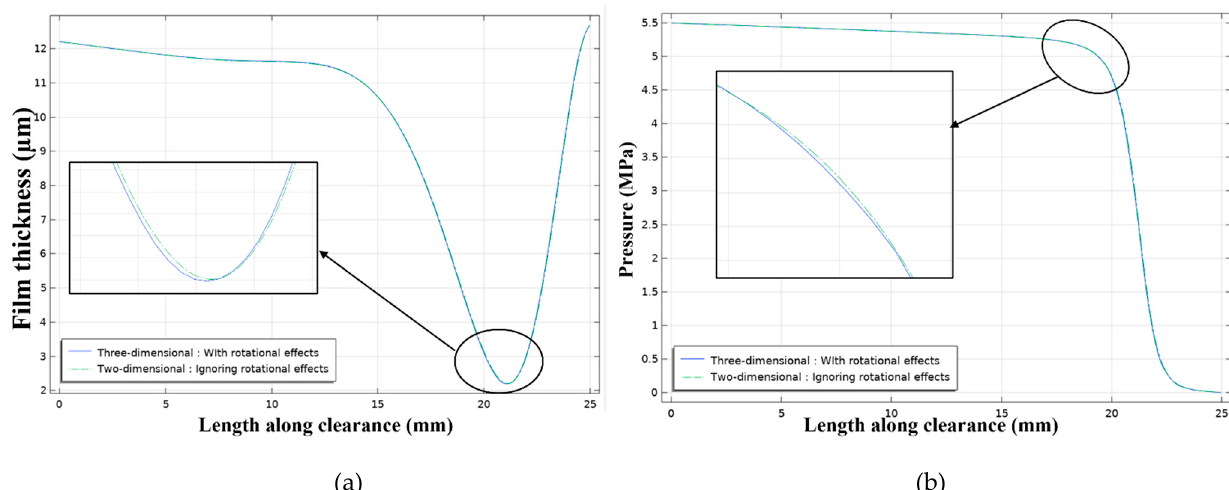
Figure 10. Comparisons of the simulations results for P 0 = 5.5 MPa: ( a ) 3D with rotational effects versus 2D without rotational effects and ( b ) 3D without rotational effects versus 2D without rotational effects.